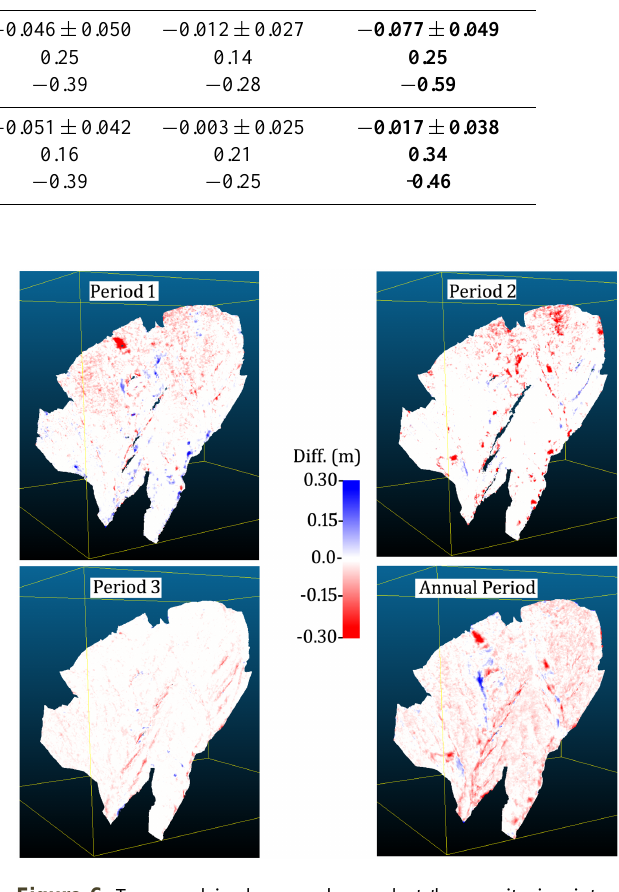
Figure 6. Topographic changes observed at the monitoring inter- vals and at annual scale obtained with SfM on north-facing slopes (CloudCompare